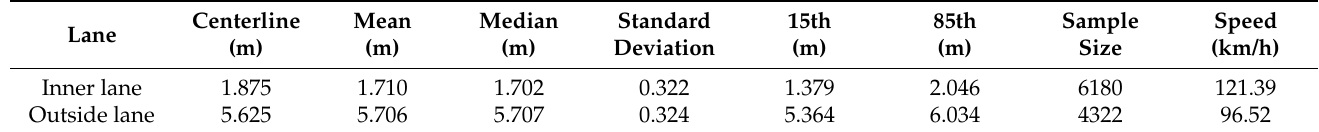
Figure 6. Preferred trajectory distribution on four-lane divided freeways. Table 2. Characteristic value of preferred trajectory deviations for four-lane divided freeways.